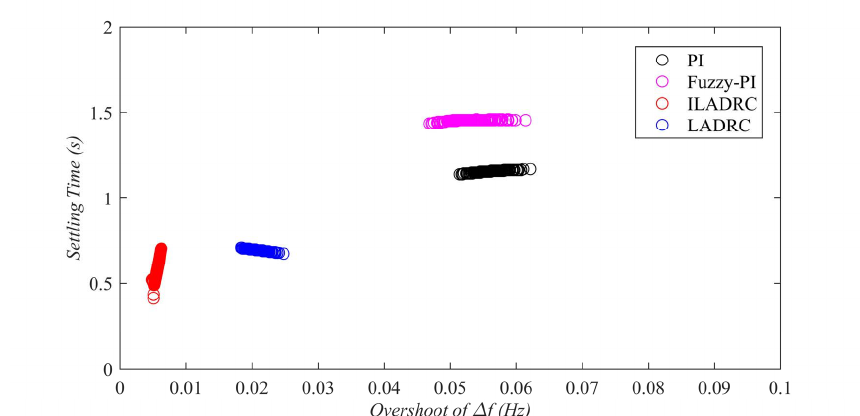
Figure 21. The comparison of robust performance testing